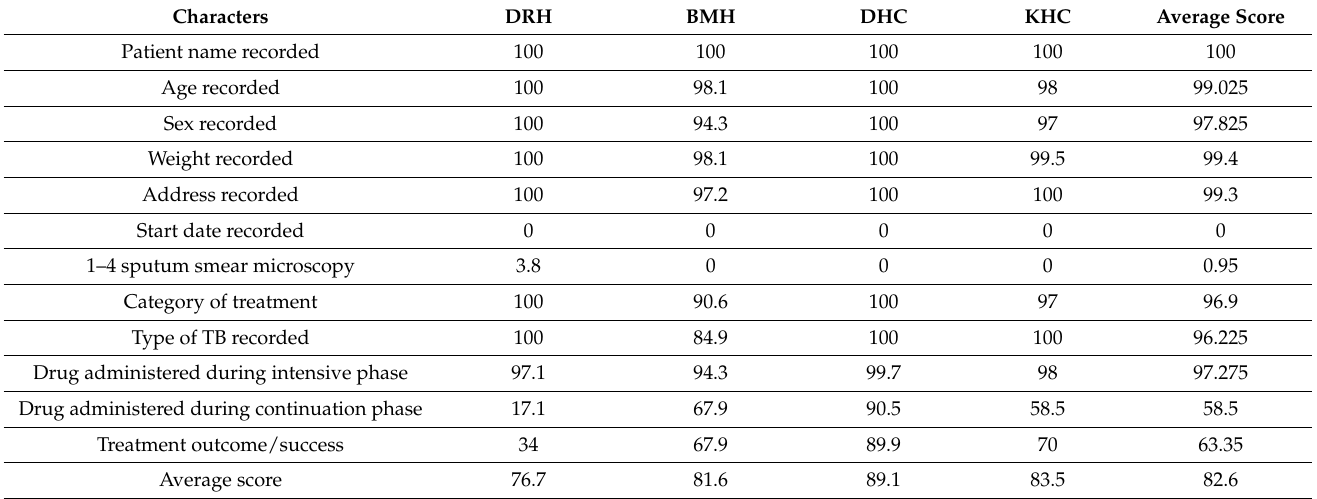
Table 3. Performance of healthcare workers in TB care and treatment delivery at public-health facilities in Northeast Ethiopia from January to April 2018.